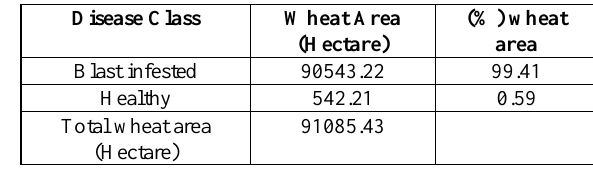
Table 1. Details of wheat area statistics for healthy and wheat blast infested